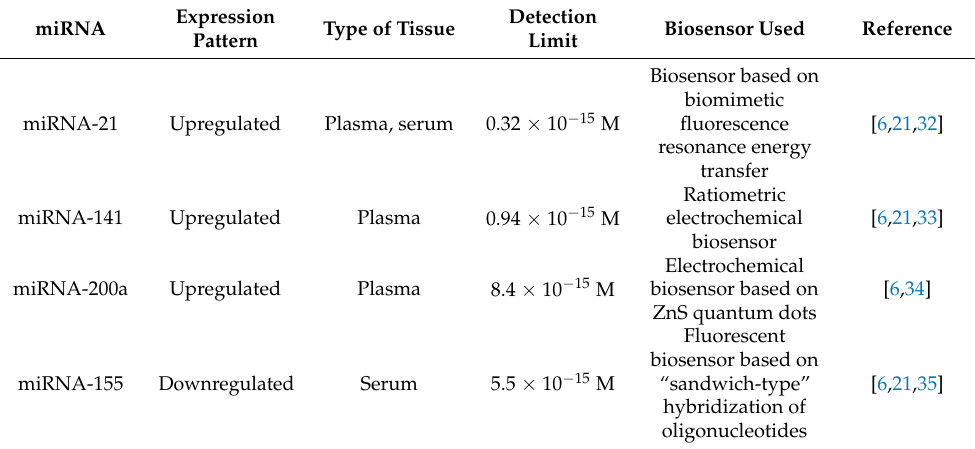
Table 1. Examples of biosensors employed for the detection of miRNAs, associated with ovarian cancer, and concentration detection limits attainable with these biosensors. Detection Expression Biosensor Used Type of Tissue miRNA Limit Pattern